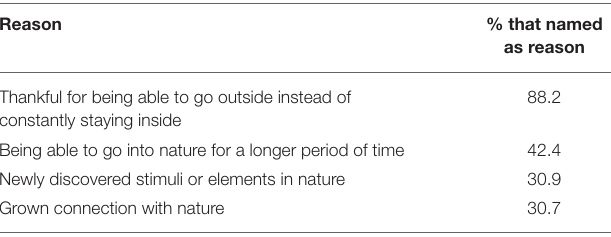
TABLE 3 | Main reasons to experience nature in a more positive way than before C19CM ( N =